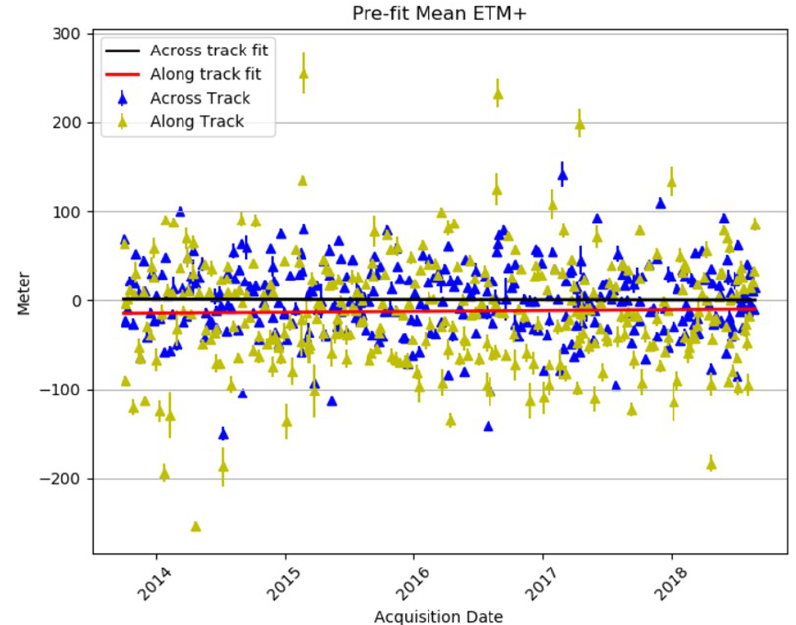
Figure 14. Geodetic accuracy for along and across track means after sensor alignment calibration. The trend for the across track direction is shown by the solid black line. The upward trend in the across track direction that was present in Figure 13 is now gone.